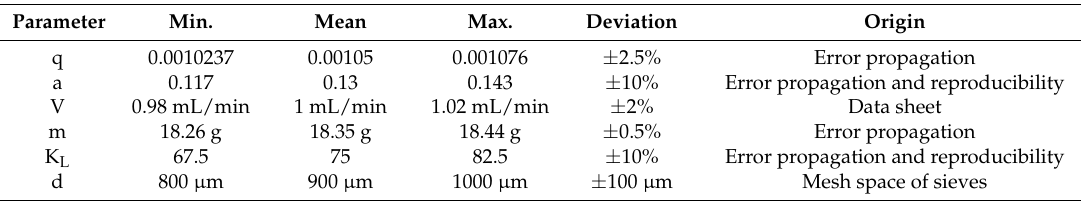
Table 4. Parameters for the sensitivity